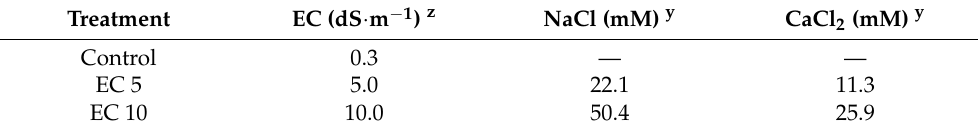
salt (NaCl and CaCl 2 ).